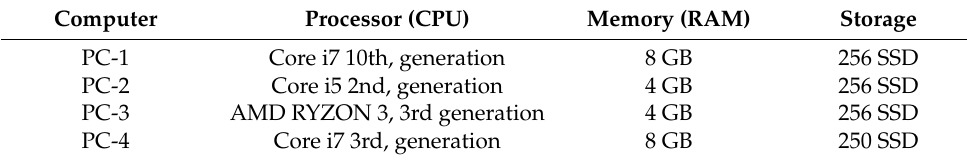
Table 1. Computers